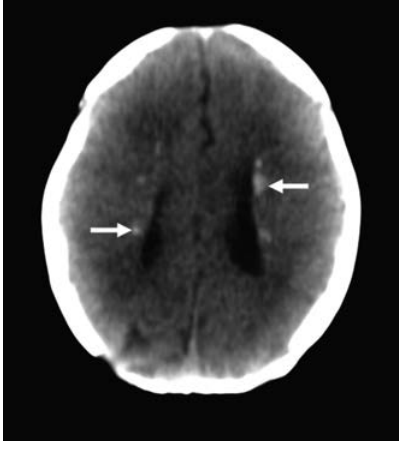
shunt.Figure 1. Unenhanced head computed tomography image shows intracranial cal- cifications in a periventricular distribution (white